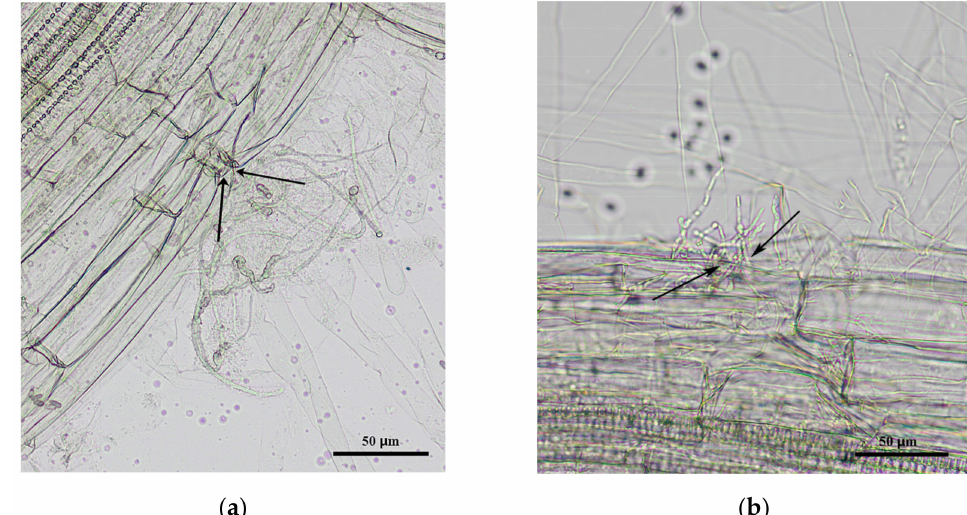
Figure A2. Root colonization by entomopathogenic fungi: ( a ) M. robertsii (strain P-72); ( b ) B. bassiana (strain Sar-31). Light microscopy (with magnification 200 × ), scale bar: 50 µ m. The areas of fungal penetration into the root tissues are shown by